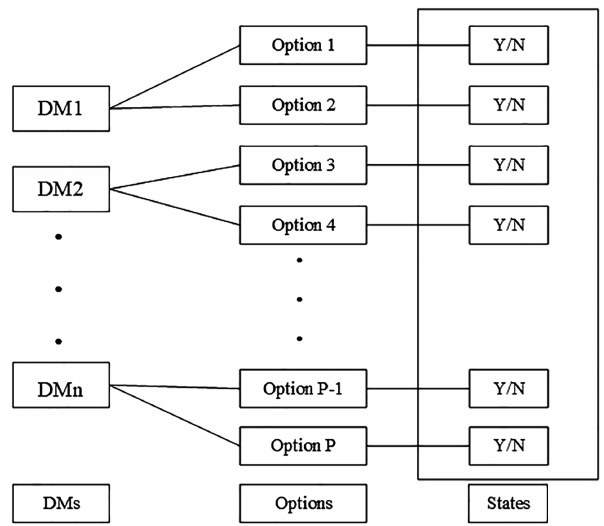
Figure 1. The modeling process of the